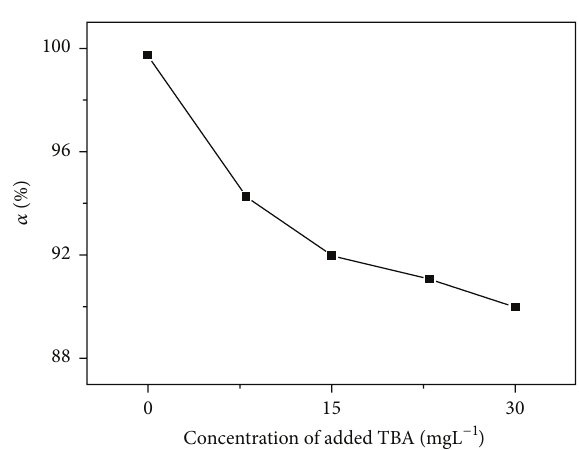
Figure 7: The degradation rate of the